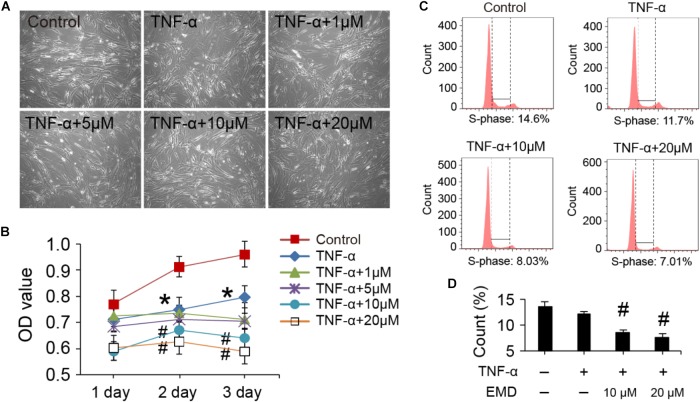
Viability and cell cycle of hVICs with treatments at the concentration of EMD ranging from 1 to 20 μM. (A) Morphologies of hVICs with different treatments for 3 days. (B) Cell proliferation curve from cck8 assay, n = 5. (C,D) Cell cycle analysis, (S-phase) were counted and made statistical comparison. ∗p < 0.05 (vs. control) and #p < 0.05 (vs. TNF-α) were accepted as significant difference, n = 3.